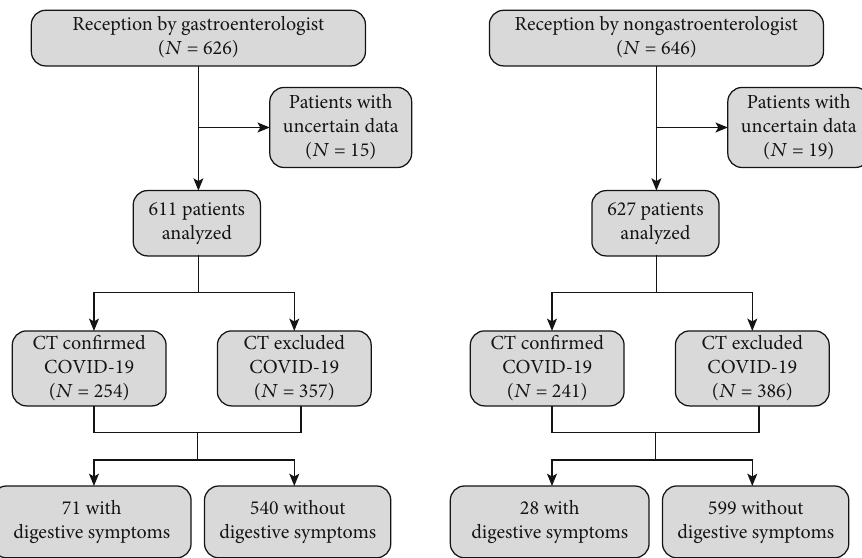
Figure 1: Study protocol and disposition of study